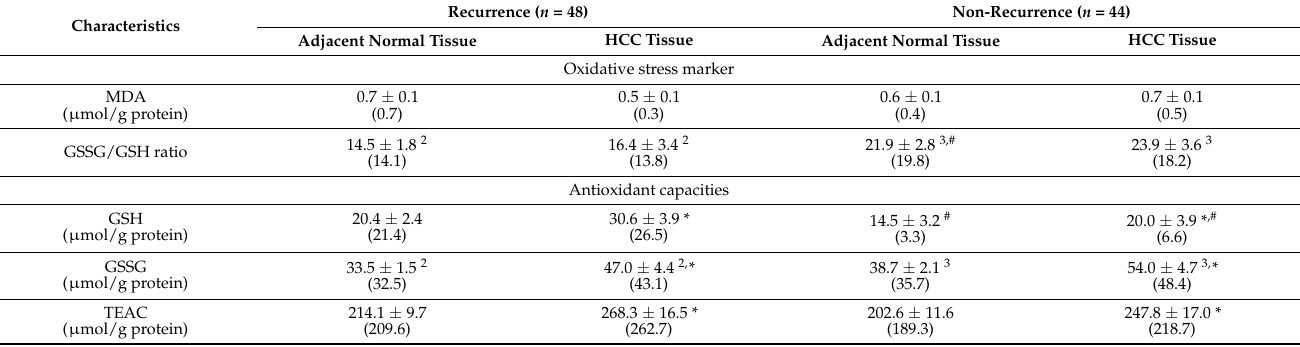
Table 4. Indicators of oxidative stress and antioxidant capacities of liver tissue in patients with recurrent and non-recurrent hepatocellular carcinoma 1